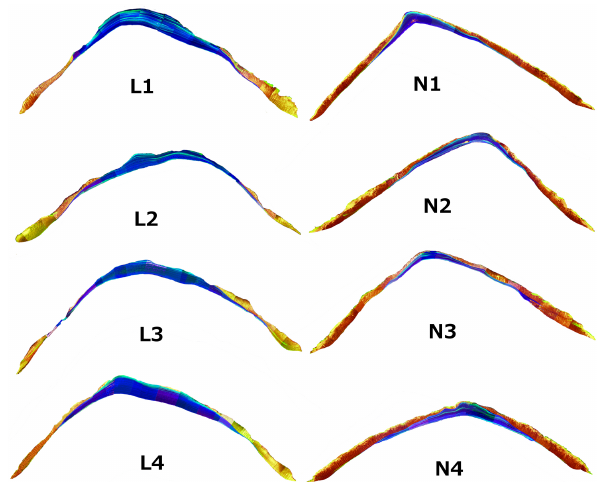
Figure 4. Polymorph distribution of transversally sectioned shells. Blue=aragonite, yellow=calcite. Normal=pH n -shells, low=pH low -shells.